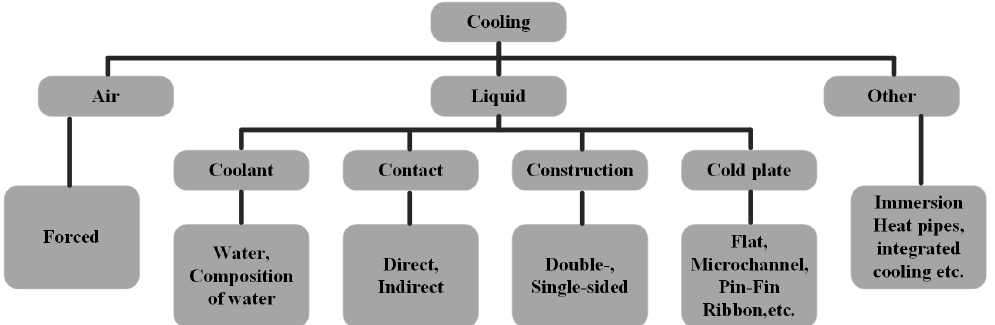
Figure 12. Different cooling methods for PE cooling